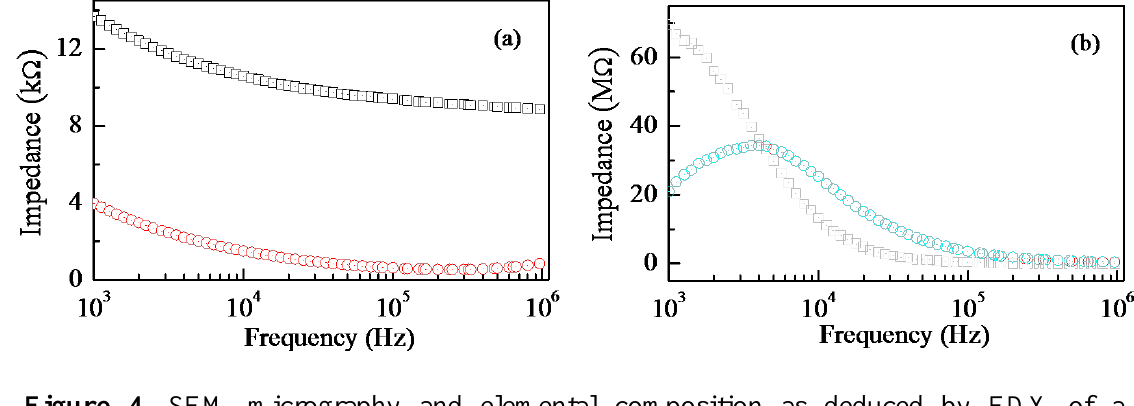
Figure 4. SEM micrography and elemental composition as deduced by EDX of a Nafion:Cu film ( a , b ), and of a film deposited from the Nafion:Cu-MWCNTs mixture ( c , d